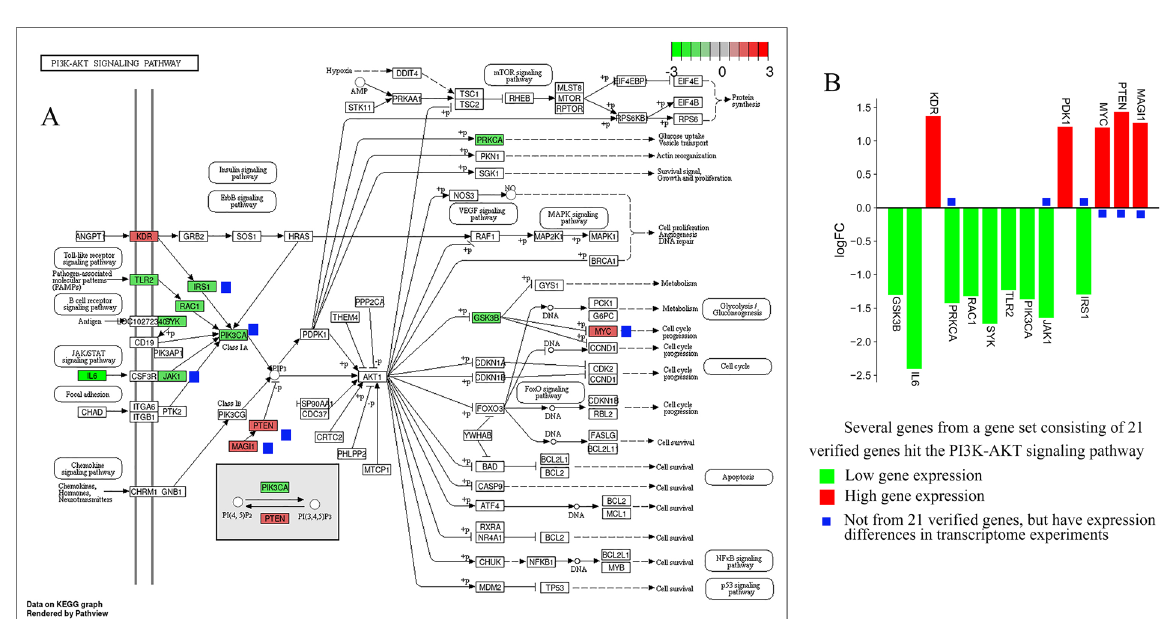
Figure 11. ( A ) Pathway mapping of the PI3K-Akt pathway. Green indicates down-regulation and red indicates up-regulation. ( B ) The expression of related genes in the PI3K-Akt pathway detected by the gene